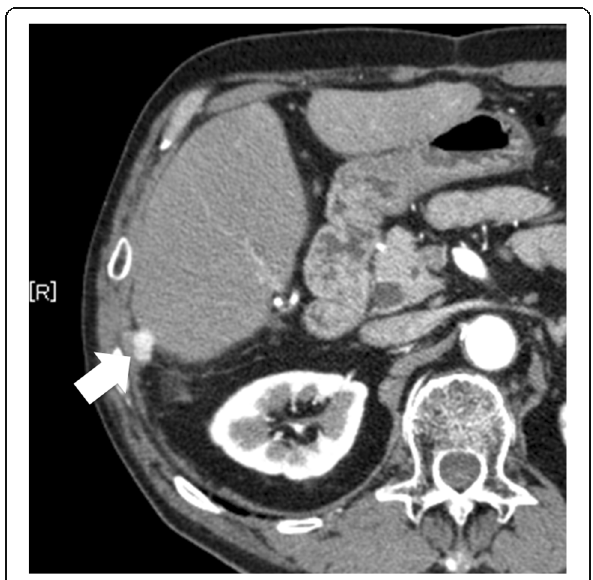
Fig. 1 Contrast-enhanced computed tomography findings. Contrast- enhanced computed tomography revealed a peritoneal metastatic lesion of 12 mm in diameter on the abdominal wall near the cut surface of the liver, with enhancement in the arterial phase (arrow)